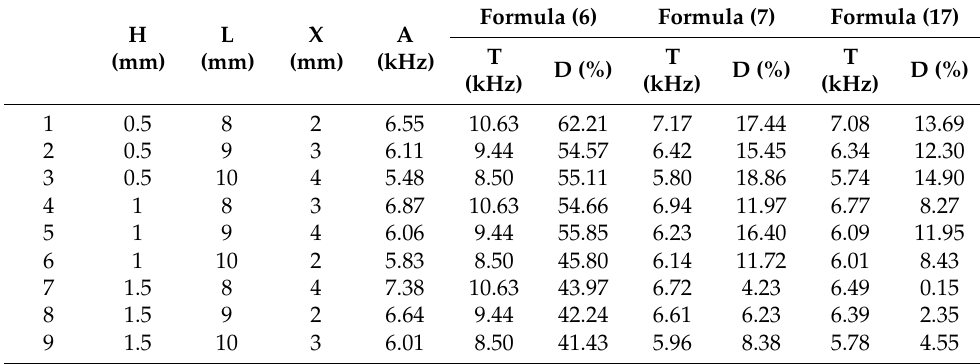
Table 7. Theoretical and experimental values of frequency empirical